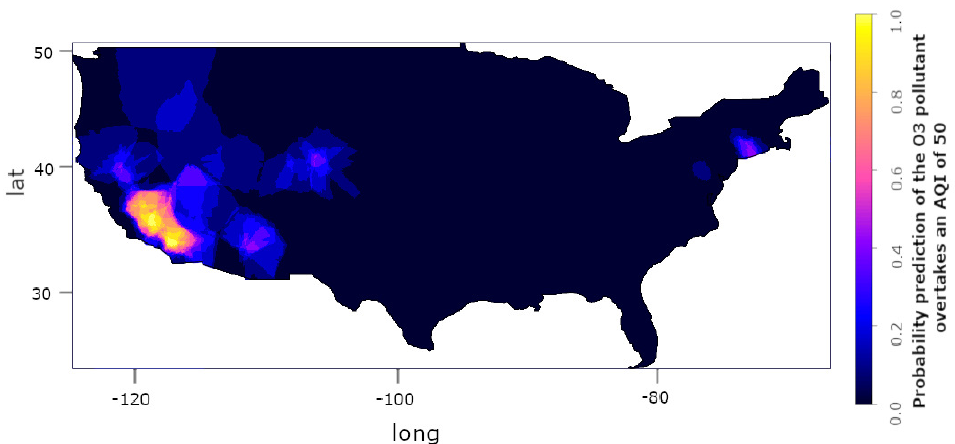
Figure 13. Kriging method indicative applied to O 3 AQI in the United States (2015); the probability prediction that the O 3 pollutant overtakes an AQI of